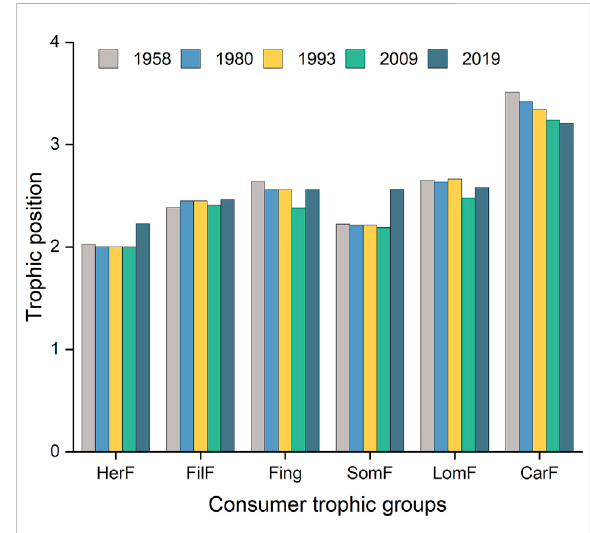
FIGURE 3 Temporal changes in the trophic positions of the six fi sh consumer trophic groups: CarF, carnivorous fi sh; FilF, fi lter- feeding fi sh; Fing, fi ngerlings; HerF, herbivorous fi sh; LomF, large omnivorous fi sh; SomF, small omnivorous fi